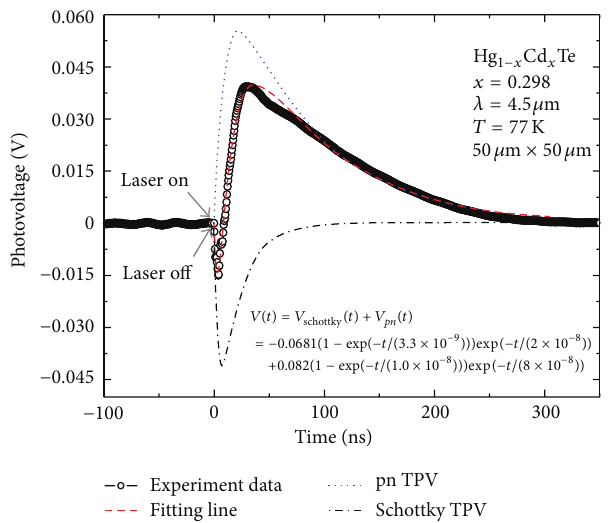
Figure 5: Pulsed PV response profiles from HgCdTe photodiode illuminated with 4.5 𝜇 m laser pulses. The circle points are the experiment results, and the dash line is the fitting curve obtained by using the theory model. The dot line and dash dot line present the simulation of pn and Schottky potential PV response,